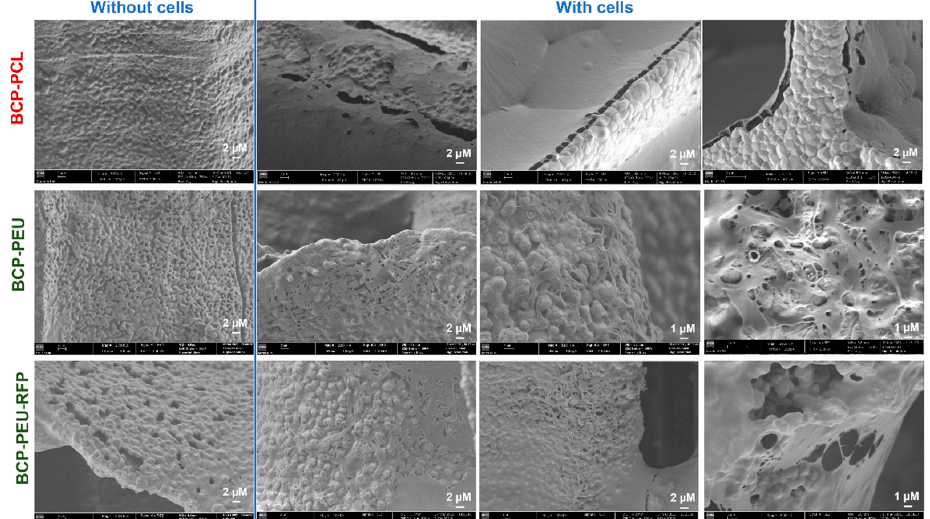
Figure 8. SEM micrographs of the surface of BCP-PCL, BCP-PEU and BCP-PEU-RFP scaffolds after polymer impregnation, without and with hMSCs after 14 days of